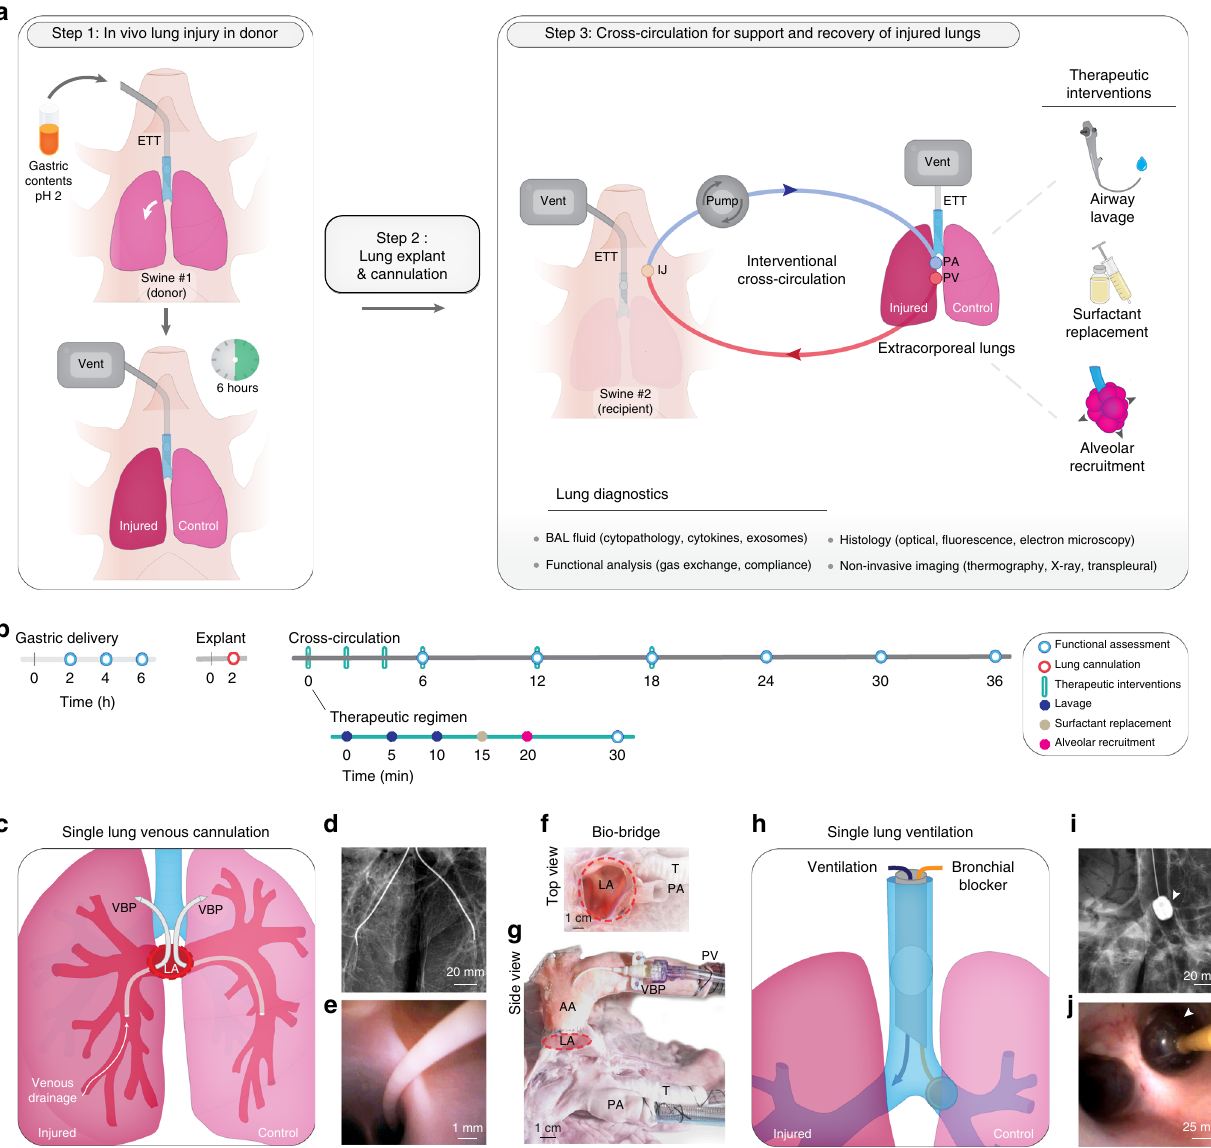
Fig. 1 Experimental overview and technique for single lung functional assessment. a Setup of interventional cross-circulation procedures. Lungs were subjected to injury in vivo by aspiration via bronchoscopic delivery of standardized gastric contents, explanted after 6 h, cannulated, and recovered by cross-circulation. ETT endotracheal tube, IJ internal jugular vein, PA pulmonary artery, PV pulmonary vein. Detailed descriptions and photographs of in vivo injury, lung cannulation procedures, and cross-circulation equipment and setup are available in Supplementary Fig. 1 – 3 and Supplementary Movie 1. b Timeline of gastric aspiration injury and lung recovery by therapeutic interventions and cross-circulation. Single lung venous cannulation technique: c Schematic of venous cannulae placed in the left and right pulmonary veins and exiting out of the left atrial (LA) cuff to venous blood ports (VBP), allowing for blood – gas analysis of venous drainage from injured and control lungs. d X-ray con fi rming position of cannulae within the left and right pulmonary veins. e Fiber optic image con fi rming cannulation of a pulmonary vein. Management of pulmonary venous drainage. f LA cuff after removal of the heart, shown in relation to the pulmonary artery (PA) and trachea (T). g Lungs fully cannulated prior to cross-circulation. Aortic arch (AA) serving as a bio-bridge between the LA cuff and the pulmonary venous (PV) drainage cannula. Placed and secured through the bio-bridge are selective VBPs (only one VBP is visualized on this side view). Single lung ventilation technique: h Schematic of bronchial blocker placed in one main stem bronchus, enabling isolated ventilation and data acquisition from a single lung. i X-ray con fi rming position of bronchial blocker within main stem bronchus with balloon in fl ated (arrow). j Bronchoscopy showing balloon in fl ated (arrow) and secured in main stem bronchus of unventilated